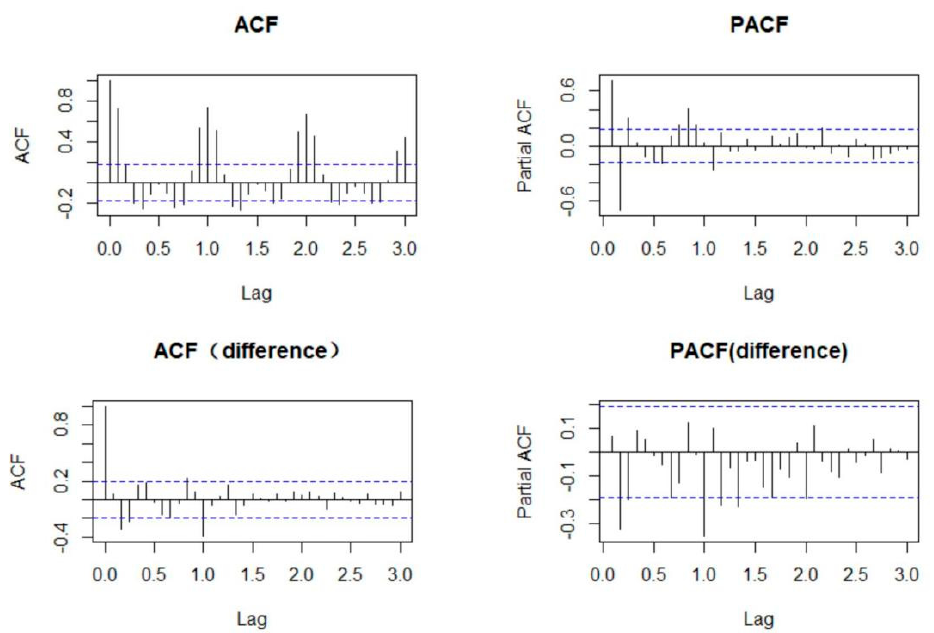
Figure 2. Sequence diagram of mumps: ( a ) Reported monthly mumps cases from Janu- ary 2009 to December 2019; ( b ) monthly mumps cases after difference.